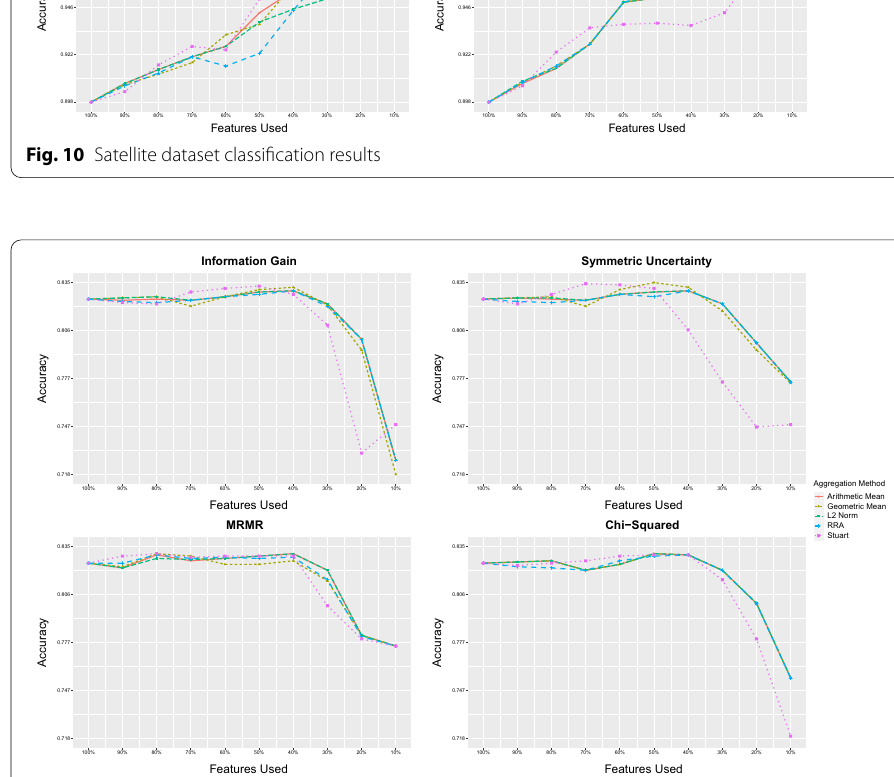
Fig. 11 Ada dataset classification